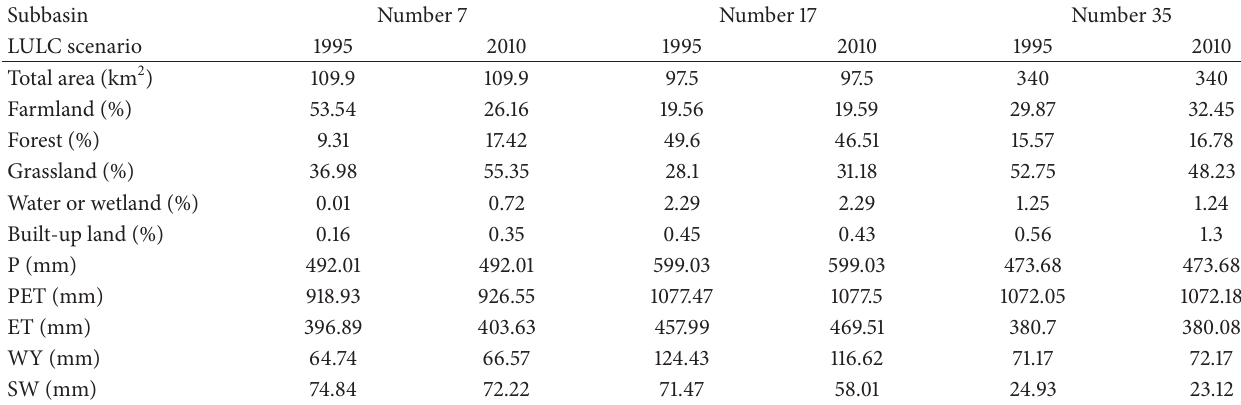
Table 6: LULC changes and average annual hydrologic features from 1992 to 2000 of three subbasins. Subbasin Number 7 Number 17 LULC scenario